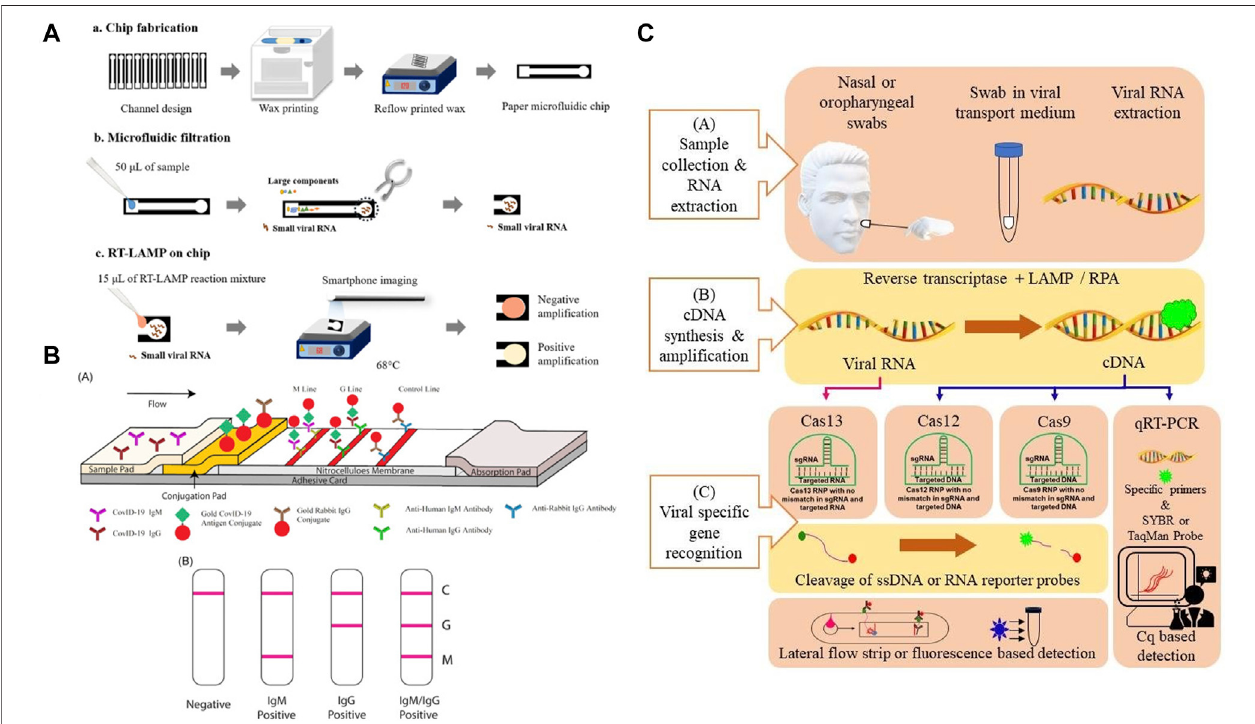
FIGURE2|(A) PrincipleofatypicalNucleicacidampli fi cationtest.Adaptedwithpermissionfrom(Kaarjetal.,2018)underCreativeCommonslicense; (B) principle ofatypicallateral fl owtest.Adaptedwithpermissionfrom(Lietal.,2020)underCreativeCommonslicense; (C)